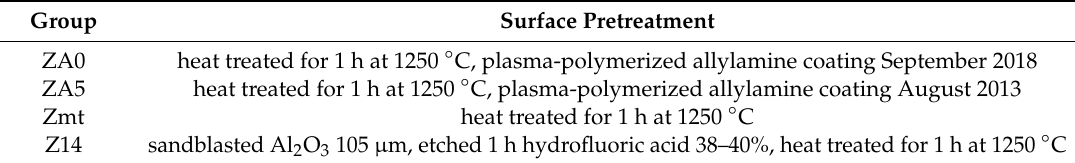
Table 1. Pretreatment of zirconia surfaces of the respective groups.